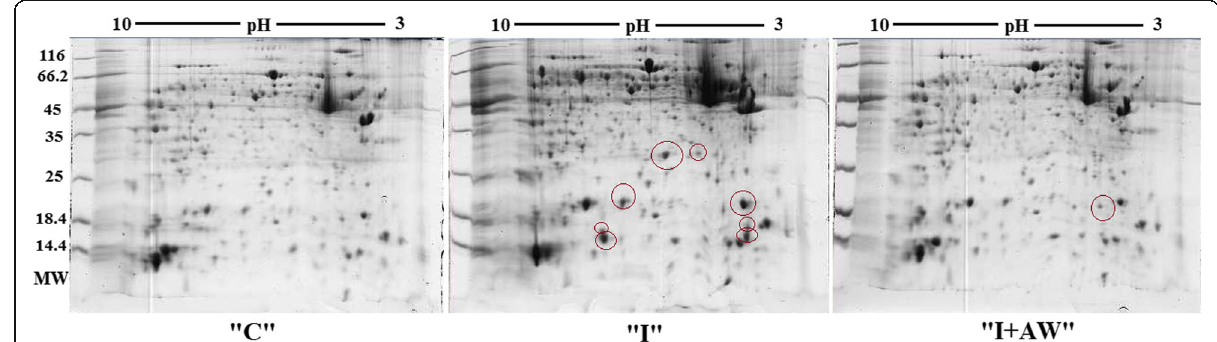
Fig. 4 The proteome profiles obtained from 2DE analysis of stomach tissues for normal ( “ C ” ), rats with indomethacin-induced ulcer ( “ I ” ) and ulcerated rats after treatment with AW extract ( “ I + AW ” ). The differentially expressed proteins are denoted by